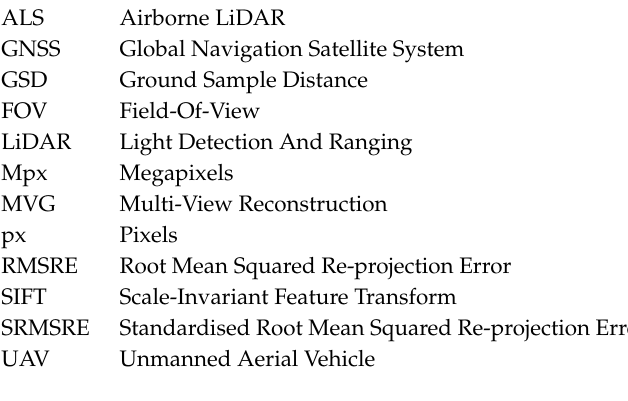
Table S1: Regression models and